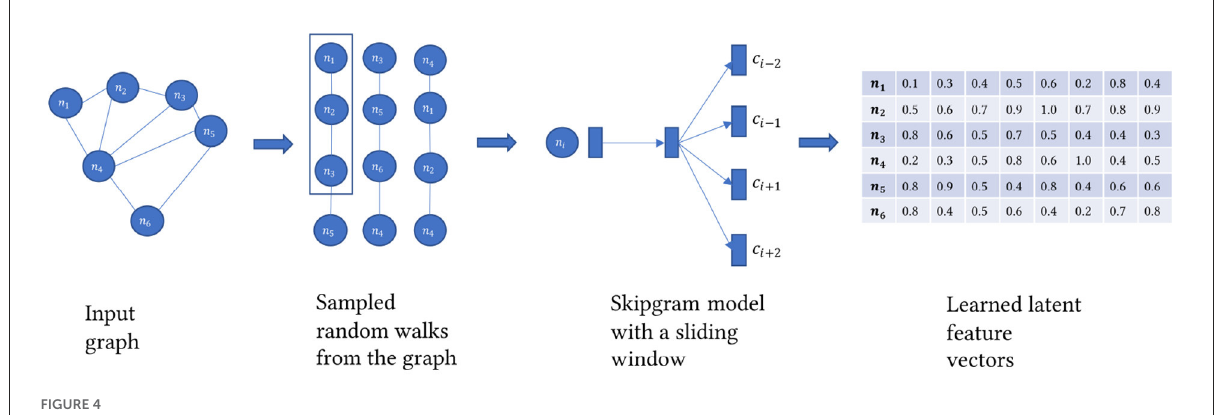
FIGURE4 A representation of the Skip-gram